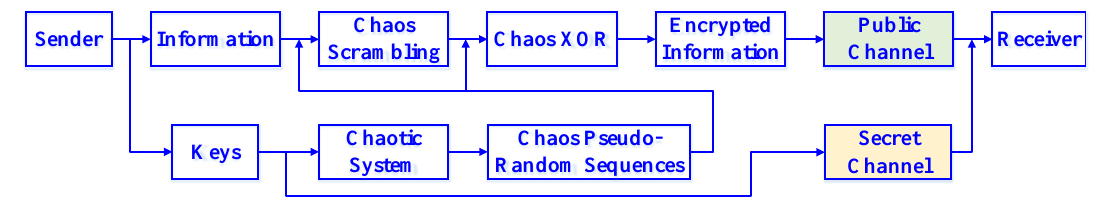
Figure 8. Design of the chaotic stream cryptographic encryption